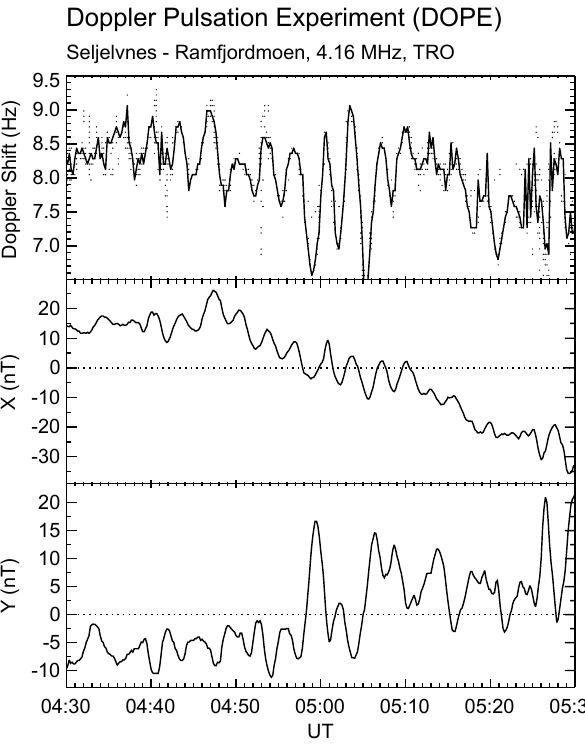
Fig. 4. DOPE and Tromsø magnetometer time series for 04:30– 05:30 UT, 24 March